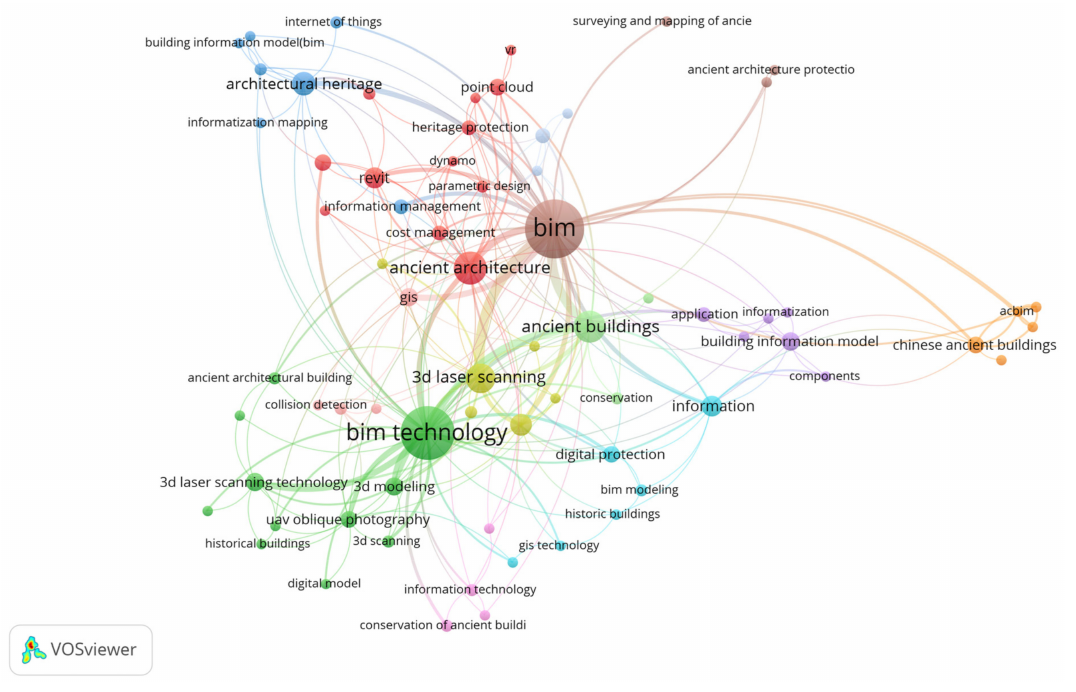
Figure 10. Network visualization of keyword for “BIM” and “architectural heritage” from the 2007 to 2022, created by VOSviewer.